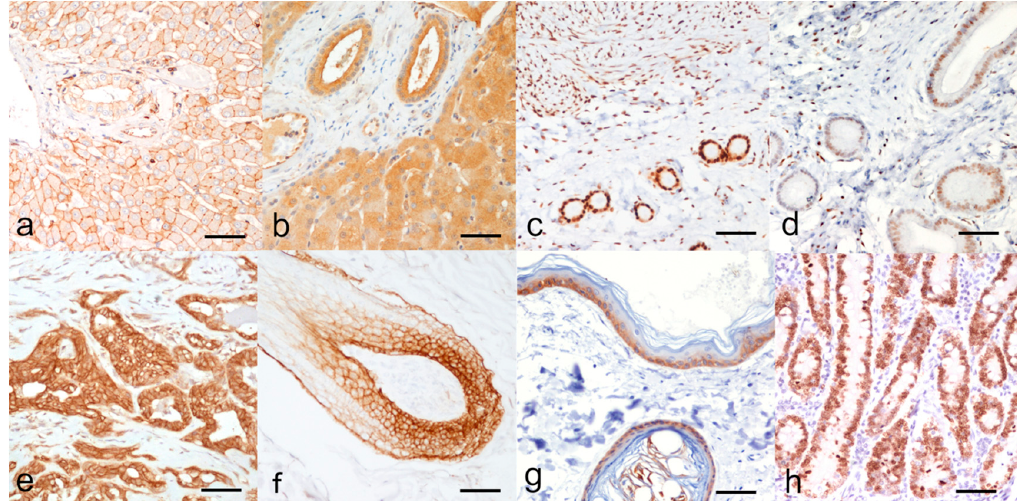
Figure 1. Immunohistochemical positive controls. ( a ) P-glycoprotein: strong immunolabeling of the plasma membrane and biliary canaliculi of hepatocytes and cholangiocytes in canine liver, ( b ) Breast Cancer resistance Protein: strong immunolabeling of the plasma membrane and cytoplasm of hepatocytes and cholangiocytes in canine liver, ( c ) Estrogen Receptor alpha: strong nuclear immunolabeling of endometrial glands, stromal cells and myometrium of canine uterus, ( d ) Progesterone Receptor: moderate to strong nuclear immunolabeling of endometrial glands and stromal cells of canine uterus, ( e ) Human Epidermal Growth Factor Receptor type 2: 3+ score, continuous, strong, membranous immunolabeling of luminal cells of canine mammary gland, ( f ) Epidermal Growth Factor Receptor type 1: strong membranous immunolabeling of epithelial cells of the follicular bulb of canine skin, ( g ) Basal cytokeratin 5 and 6: strong cytoplasmic immunolabeling of basal cells of the epidermis and follicular epithelium of canine skin, ( h ) Ki67 (MIB1 antibody): nuclear immunolabeling of cryptal enterocyte in canine small intestine. Indirect immunohistochemistry, magnification × 200, bar = 200 μ m.